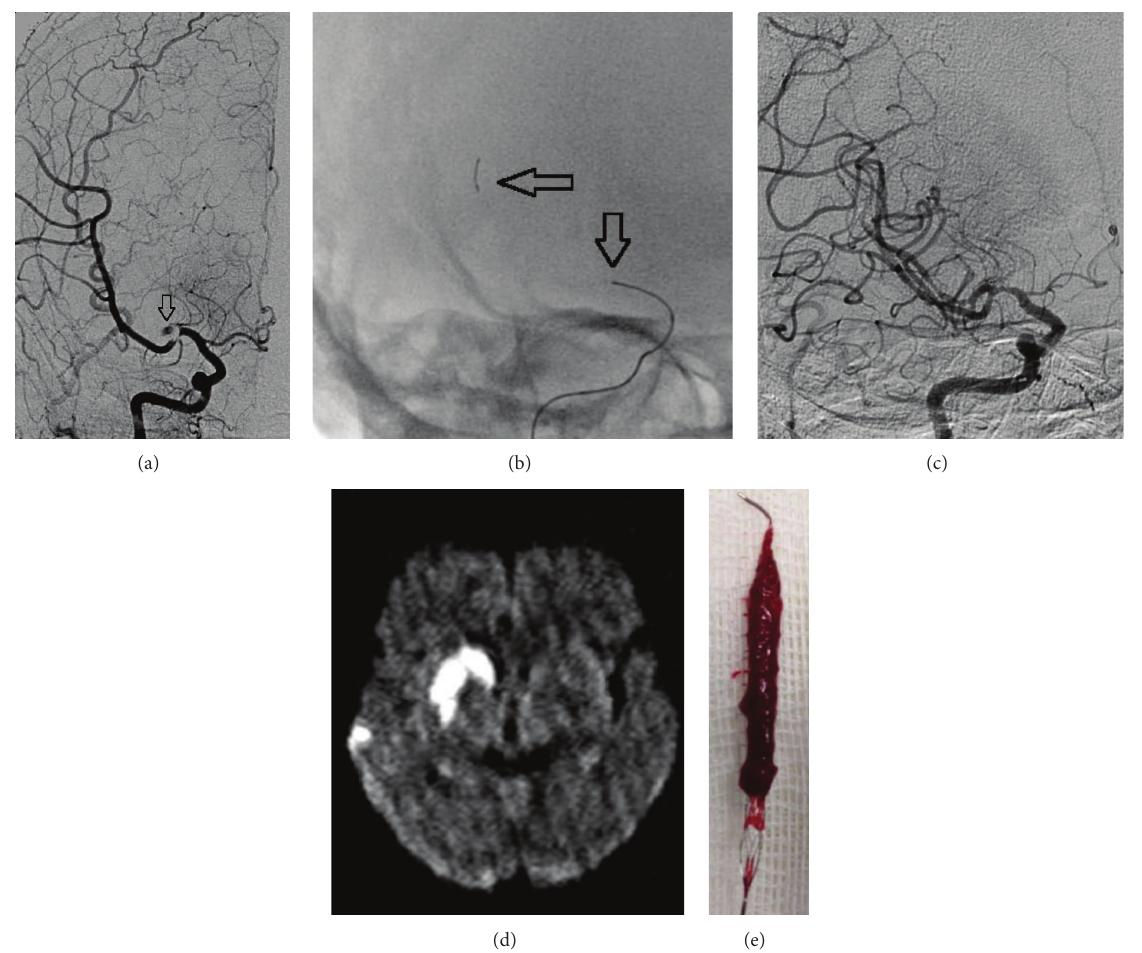
Figure 1: (a) Angiogram shows a thrombus on proximal MCA and an occlusion of superior division of MCA. (b) Deployed REV˙IVE device (distal and proximal markers = black arrow). (c) After retrieval of the stent, the vessel is recanalized to a TICI-3 state. (d) Control MRI scan shows right hemispheric striatocapsular infarction and multiple parietal small embolic infarctions. At 3 months, patients had a good outcome. (e) Large thrombus is adherent to the stent struts.